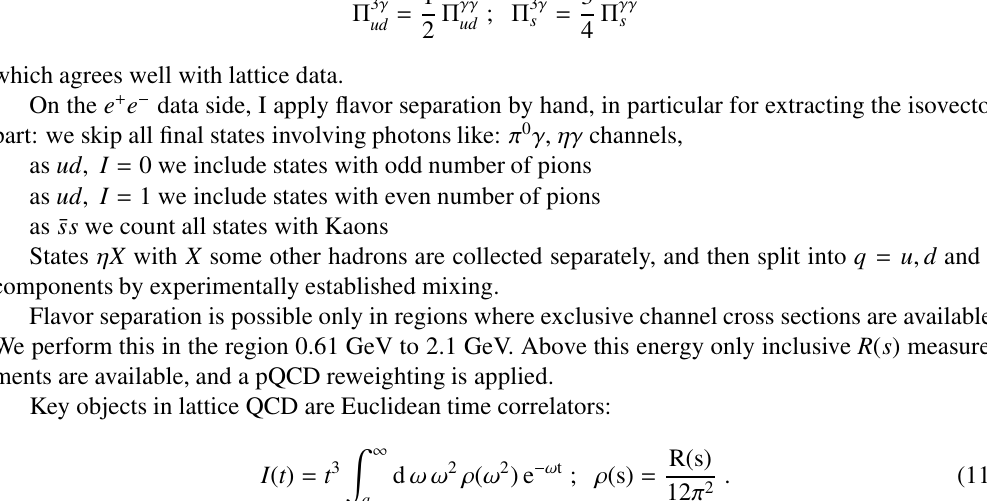
Table 2. Variants of flavor recombination of